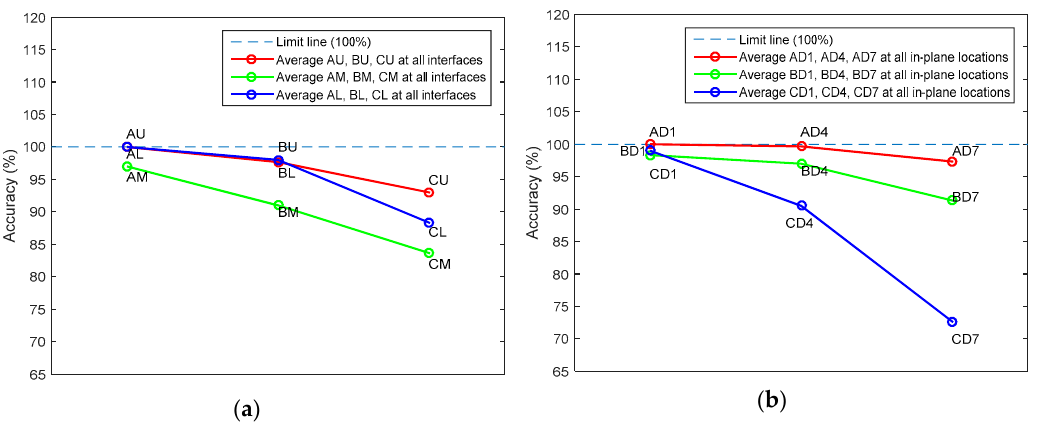
Figure 8. Average predictive performance of the pre-trained CNN with respect to: ( a ) in-plane location of delamination; ( b ) through-the-thickness interface of delamination.